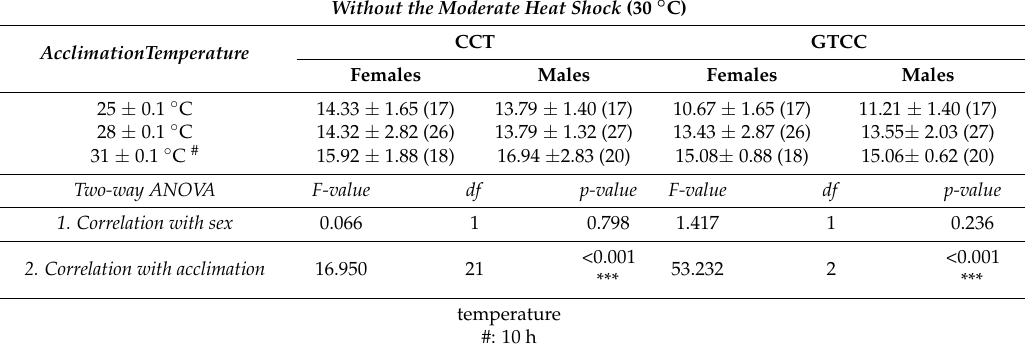
Table 2. Results of temperature acclimation experiments after acclimation for 10 or 24 h. Cool coma temperatures (CCTs) and gap temperatures for cool coma (GTHCs) were measured in adults Halobates germanus . Cool coma experiments were performed after the acclimation to 25 ± 0.1 ◦ C, 28 ± 0.1 ◦ C or 31 ± 0.1 ◦ C. Experiments were performed in December 2016 during the MR16-08 cruise in wet laboratory 2 of the R/V MIRAI.